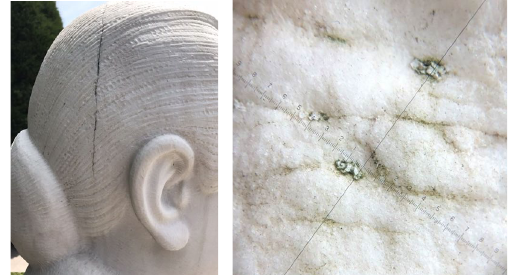
Figure 2 . Deteriorations on the statue: cracks, chalking, moss, old paint photo taken in May 2018. (Source: Tongji-ACL)